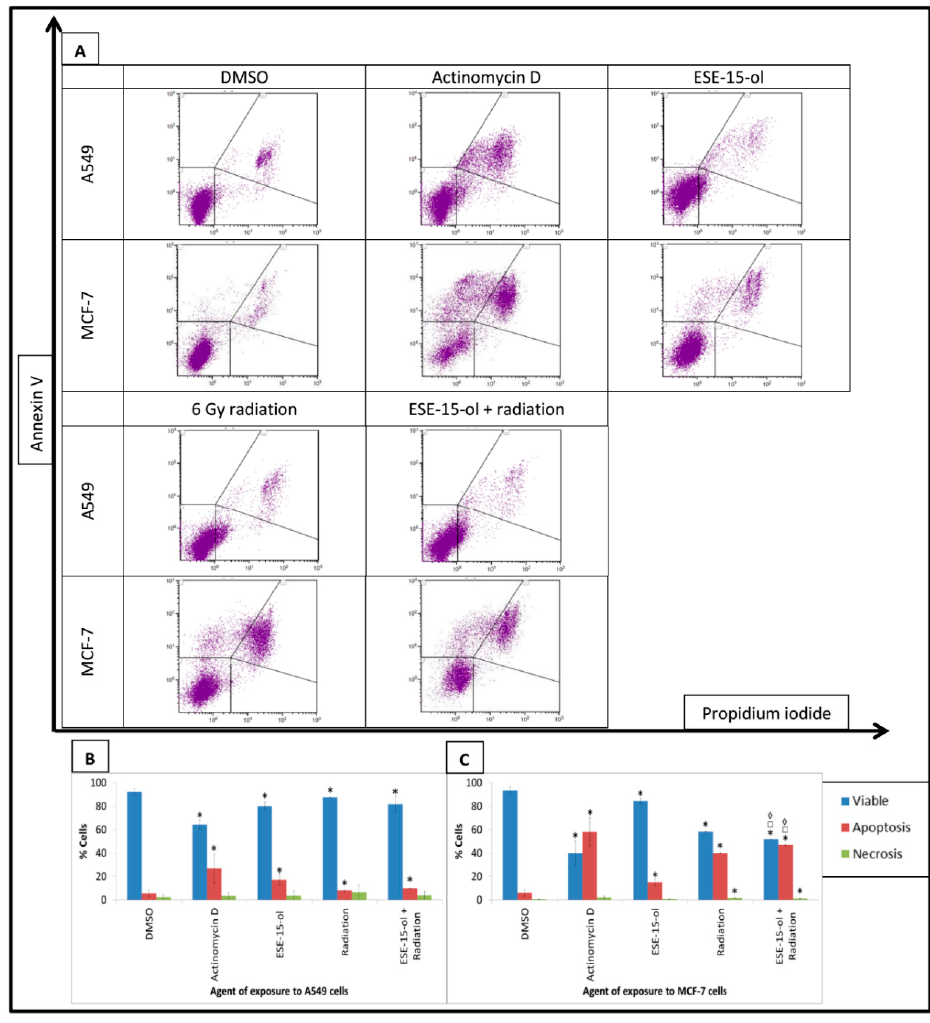
Figure 1. Annexin V-FITC detection in A549- and MCF-7 cells. Annexin V-FITC (FL1)